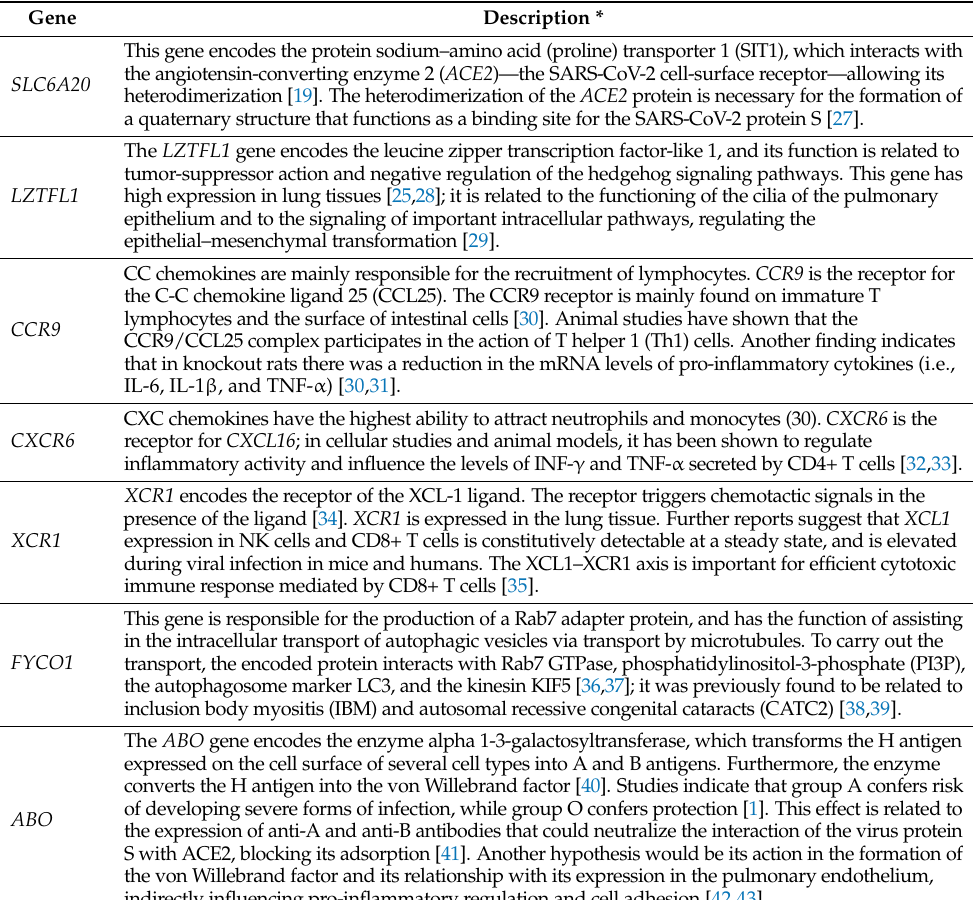
Table 1. Function of the SLC6A20, LZTFL1 , CCR9, CXCR6, XCR1, FYCO1, and ABO